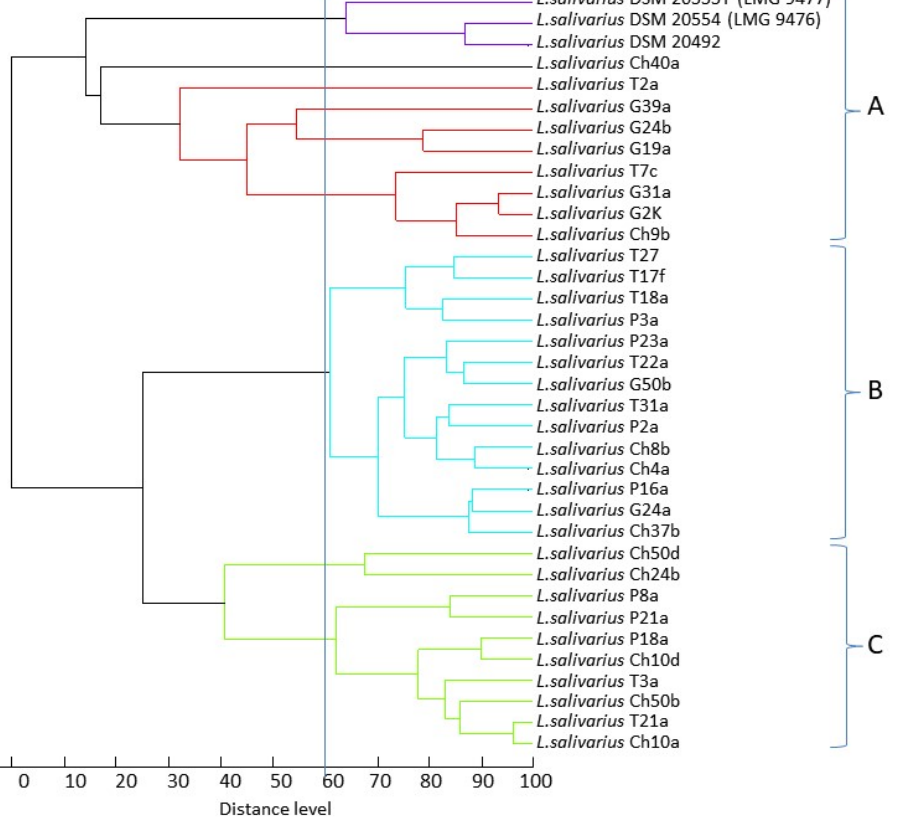
Figure 1. Dendrogram derived from UPGMA cluster analysis of MALDI-TOF mass spectra obtained from the 33 wild-type L. salivarius strains. The relative distance between isolates is displayed as arbitrary units. One hundred indicates complete similarity and 0 indicates maximum dissimilarity. The vertical line corresponds to the level of similarity 60%.